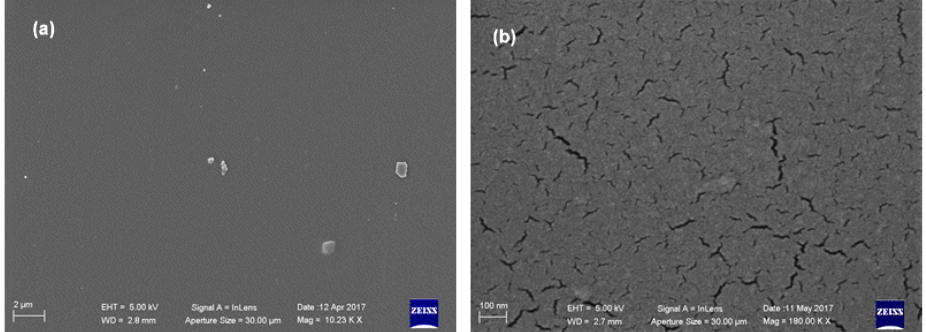
Figure 7. SEM microphotographs of PU_3810/K22/H12MDI at different magnifications: ( a ) 10 Kx; ( b ) 180 Kx.